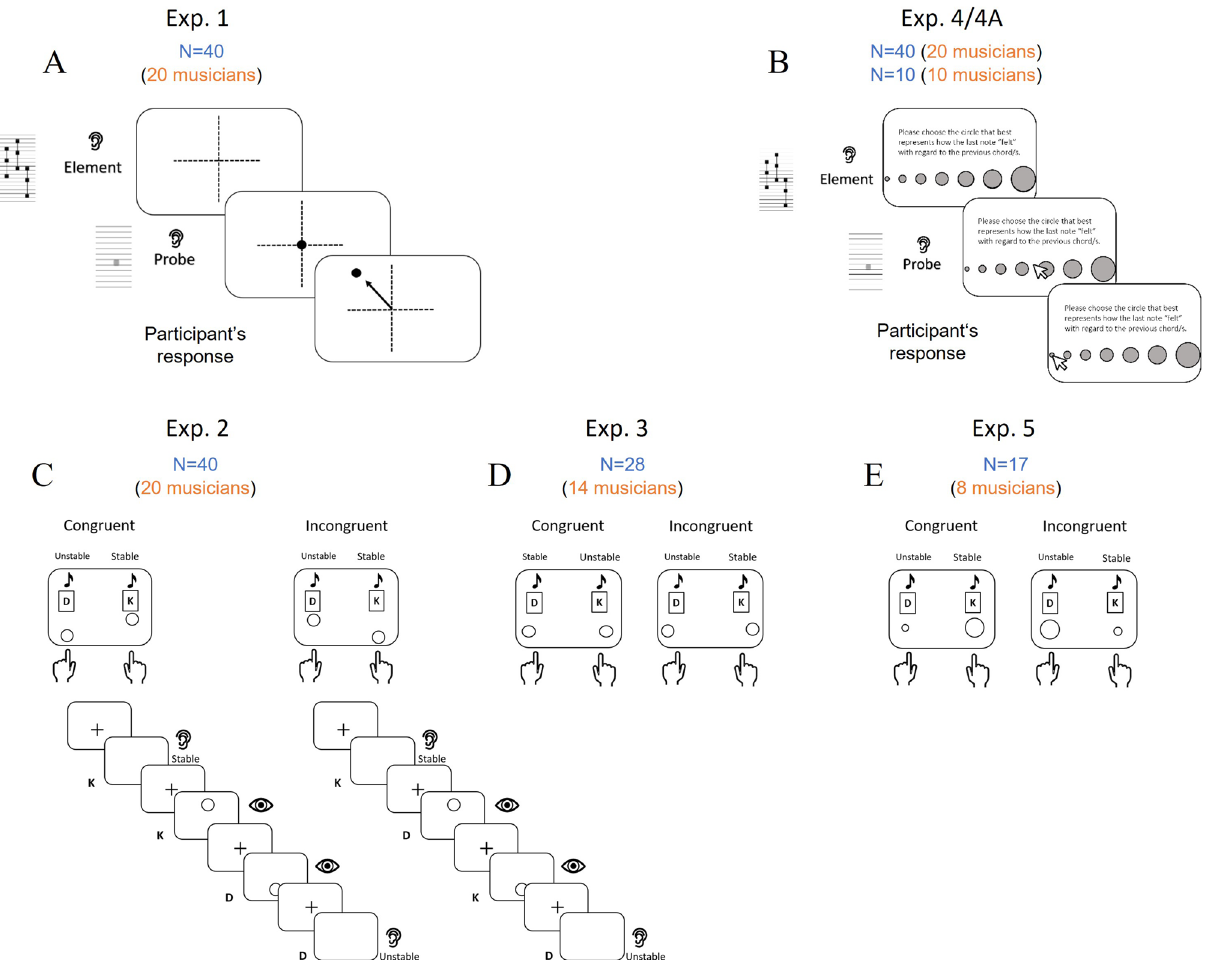
Figure 2. Graphic representation of the experimental designs in the present study. ( A ) Trial sequence in Experiment 1, probe tone paradigm 34 measuring tones’ perceived location. ( B ) Trial sequence in Experiments 4 and 4A, probe tone paradigm measuring tones’ size matchings. ( C ) Block opening screen and trial sequence of congruent (left) and incongruent (right) blocks in Experiment 2, cross modal IAT 35 measuring compatibility between tonal stability and vertical location. ( D ) Block opening screens of congruent (left) and incongruent (right) blocks in Experiment 3, cross modal IAT measuring compatibility between